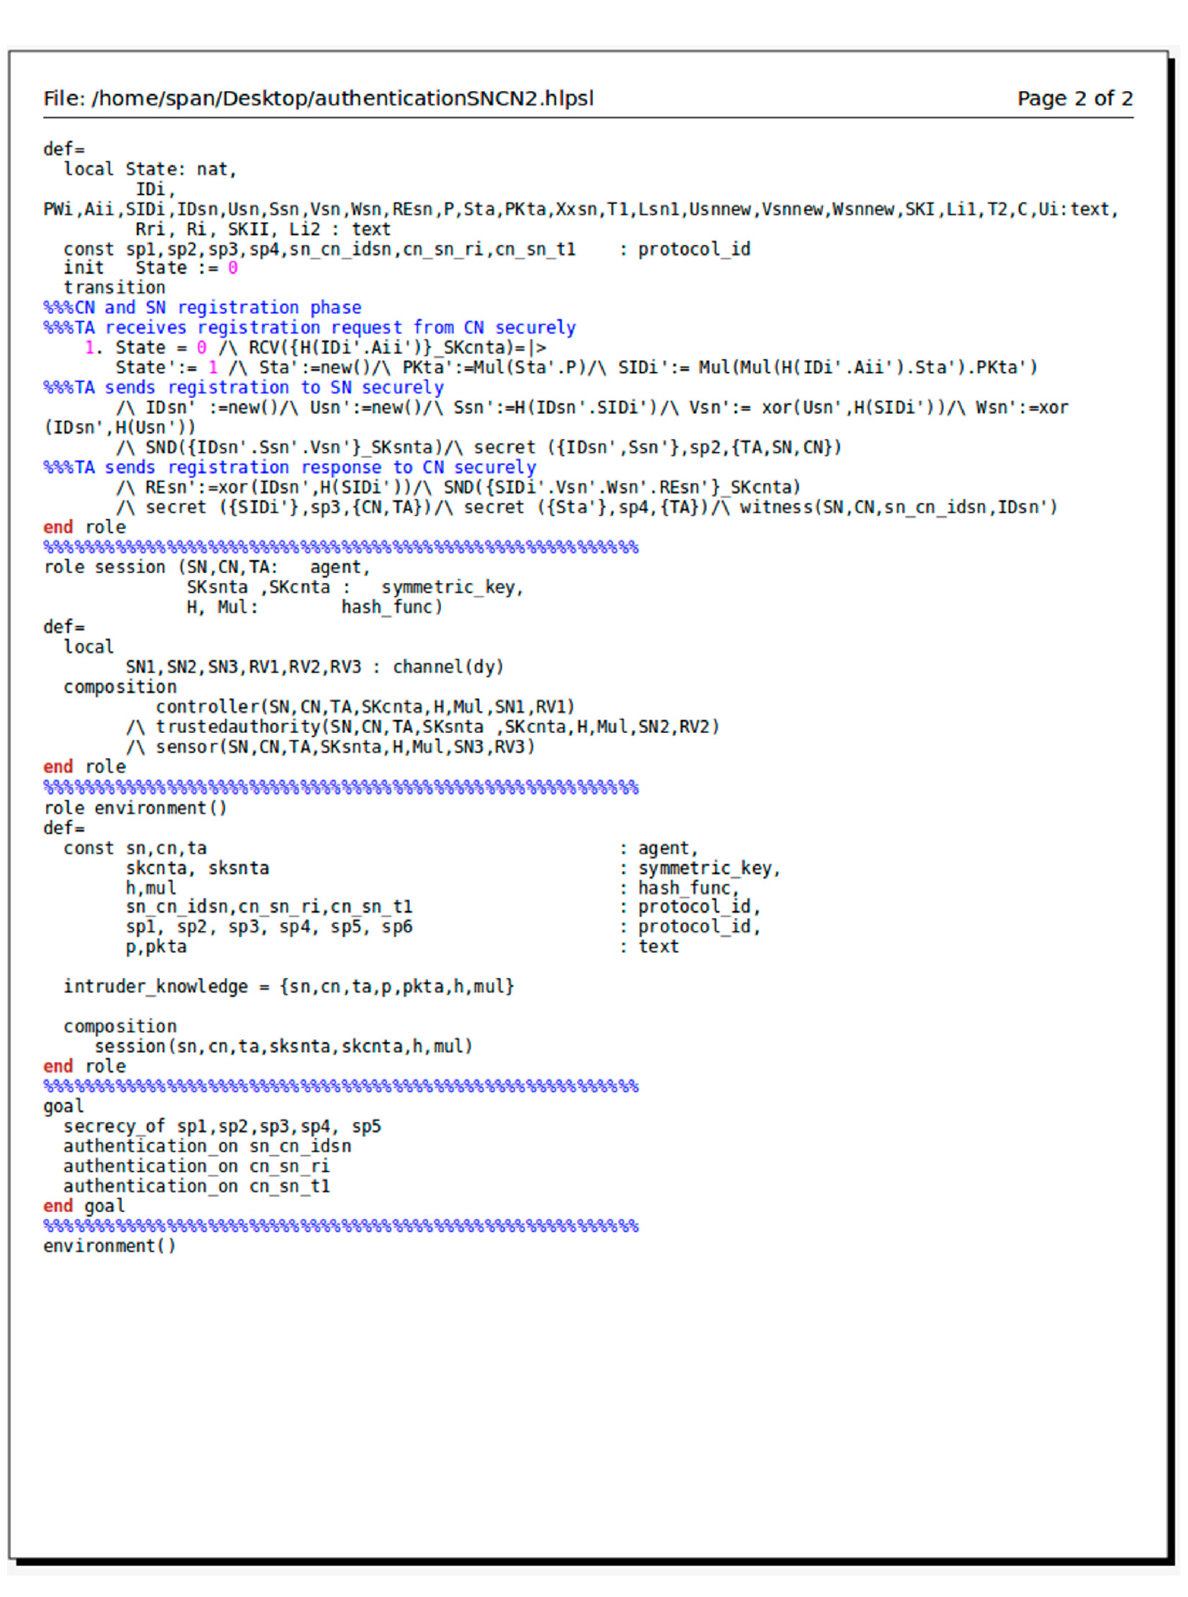
Figure 9. HLPSL code for protocol-II.